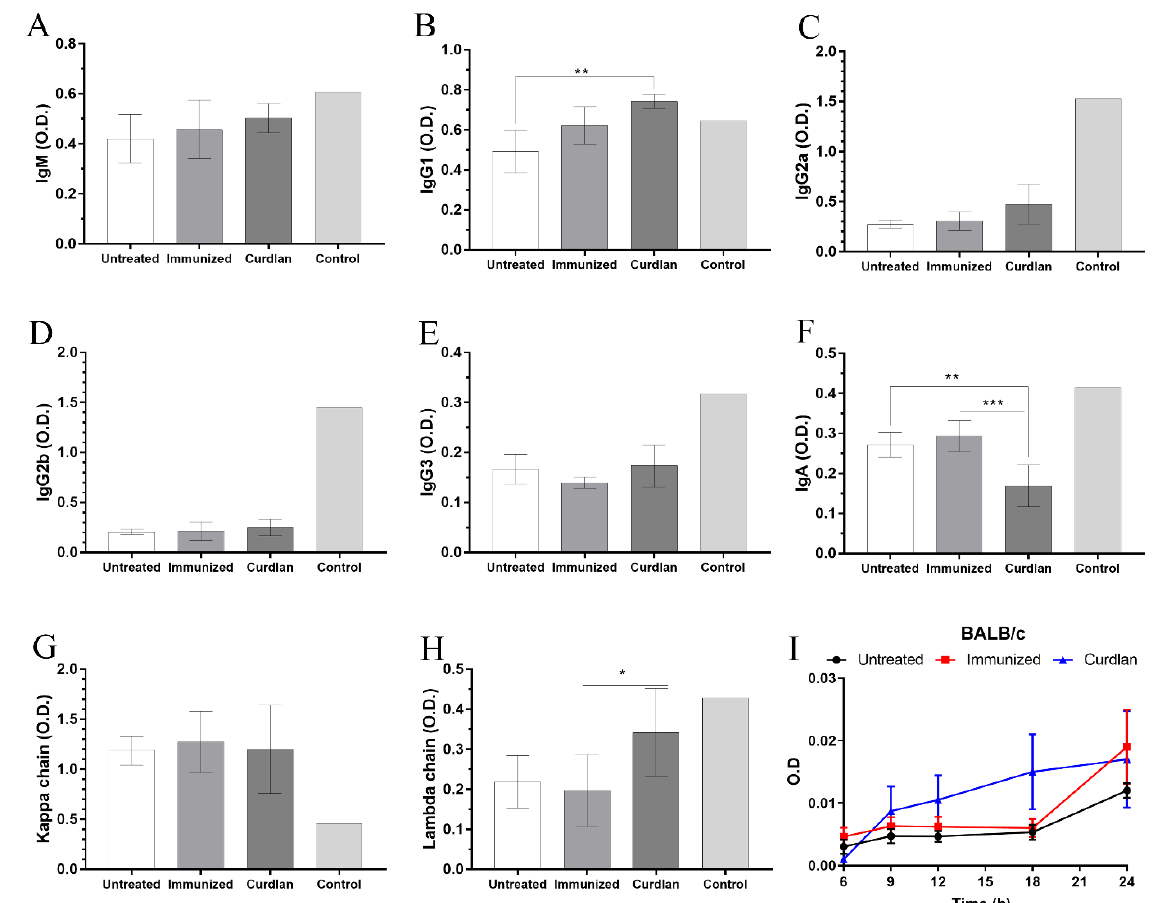
Figure 2. Isotyping of serum immunoglobulins in BALB/c mice and the effect of serum on the growth curve of C. gattii cultivated in titan cell medium (TCM). BALB/c mice immunostimulated with curdlan and/or immunized with HK- C. gattii -thin were euthanized 14 days post infection with C. gattii . The serum was collected and used for both isotyping the immunoglobulins and incubating with C. gattii to determine its growth curve. The ( A ) IgG1, ( B ) IgG2a, ( C ) IgG2b, ( D ) IgG3, ( E ) IgM, ( F ) IgA isotypes, and the ( G ) kappa and ( H ) lambda light chains were evaluated. ( I ) C. gattii R265 was cultivated at 37 °C for 24 h in TCM, and the growth curves were determined in the presence of serum from mice belonging to the untreated (black circle), immunized (red square), and curdlan groups (blue triangle). The results are expressed as mean ± SD. * p < 0.05, ** p < 0.01, and *** p < 0.001.